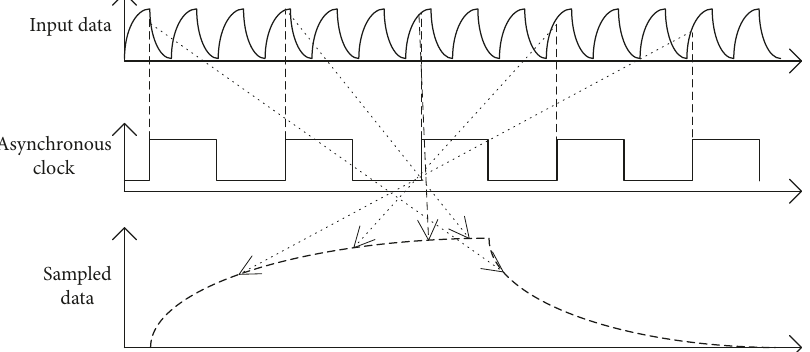
Figure 3: Asynchronous undersampling technique.